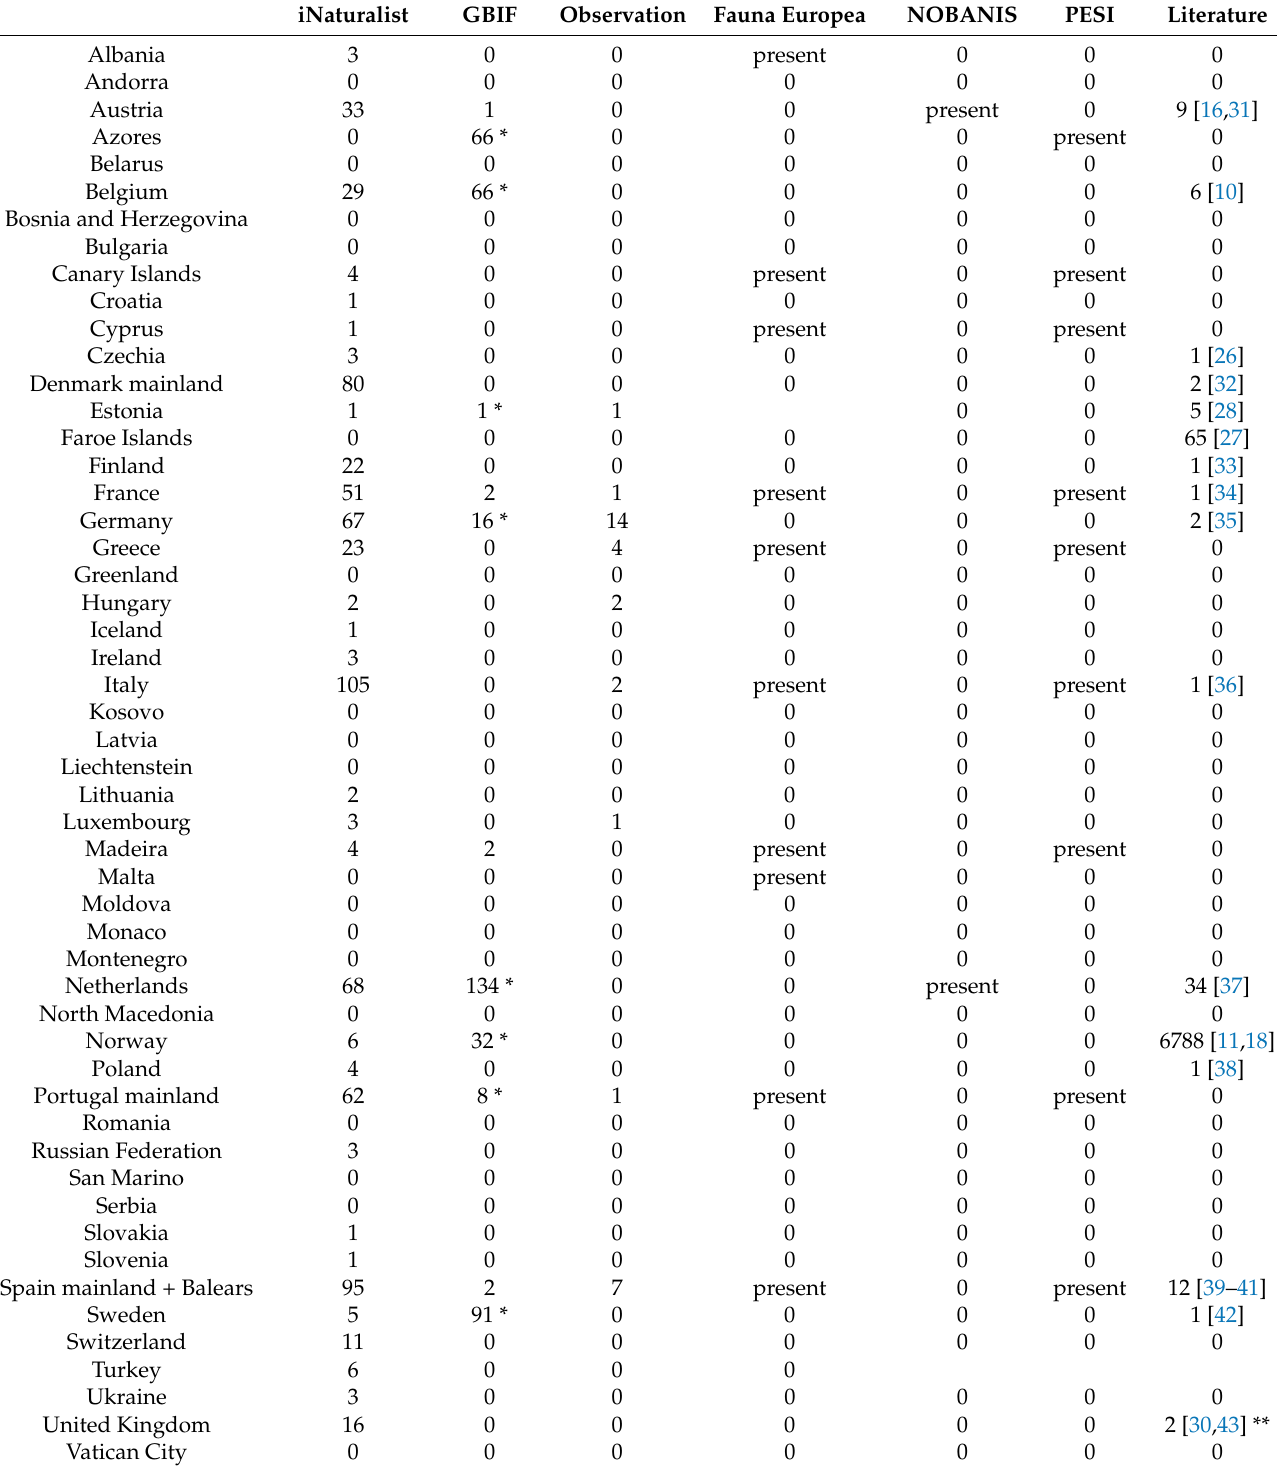
Table 4. The abundance of Ctenolepisma. longicaudatum in Europe based on online databases, namely, iNaturalist, GBIF, Observation.org, Fauna Europea, NOBANIS, and PESI and available literature